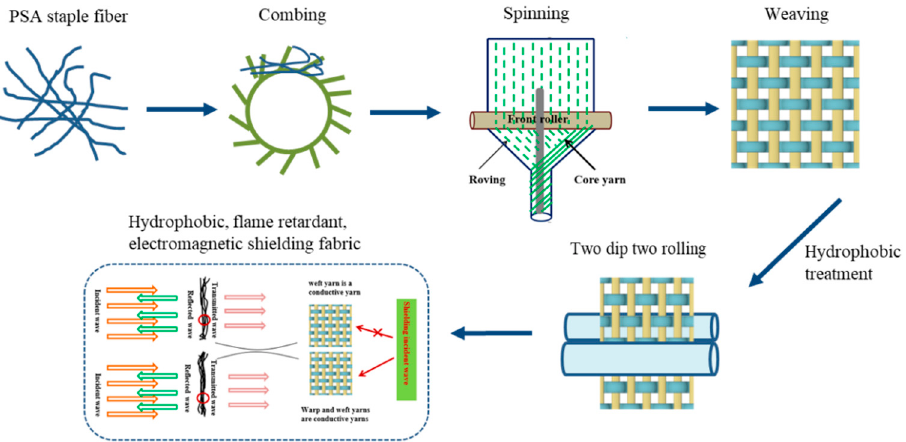
Figure 2. The schematic diagram of the processing procedures of hydrophobic / flame retardant / electromagnetic interference (EMI) shielding fabrics.